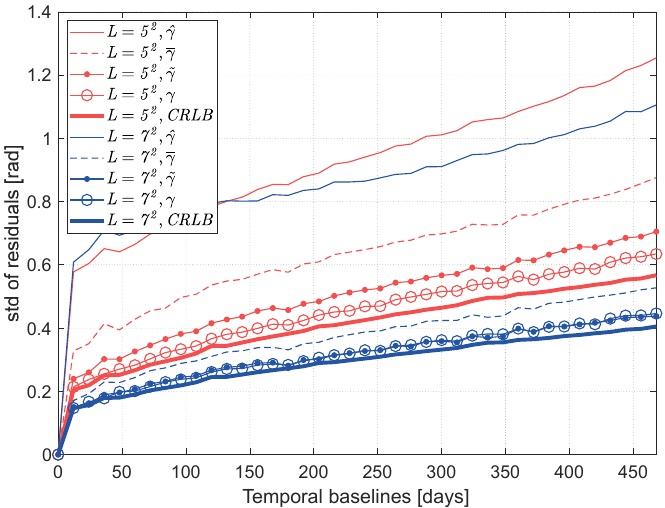
ence magnitude estimators. The colors indicate the number of looks. Figure 8. Standard deviation of the residuals for reconstructed phase series using different coherence